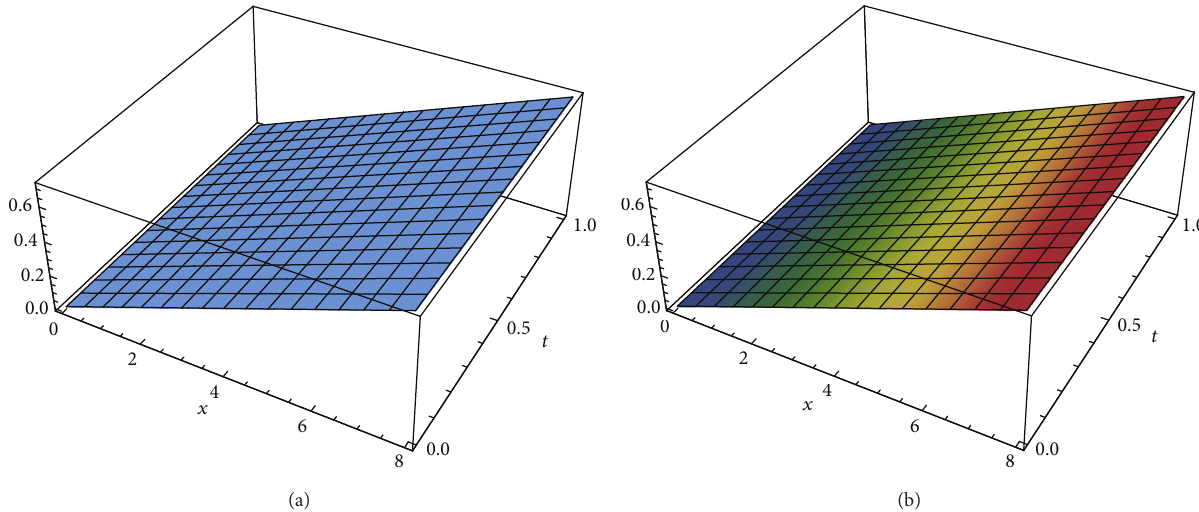
Figure 7: Three-dimensional plot for the solution of Saint Venant equations via homotopy analysis method obtained (a) V (𝑥,𝑡) = V 0 + V 1 + V V V (𝑥,𝑡) = V V 2 + 3 + 4 (b)